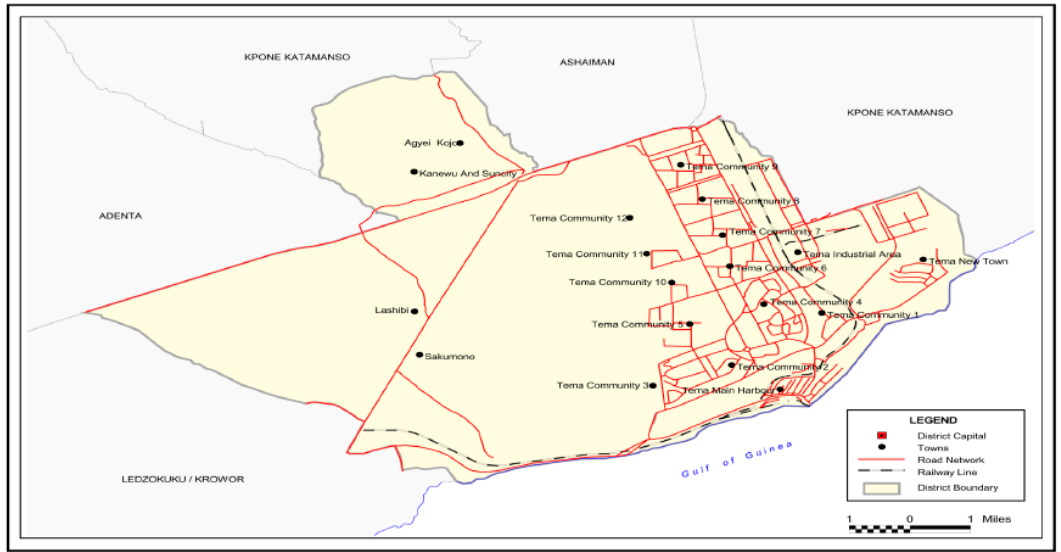
Figure 1. Map of Tema metropolitan area (Source: Ghana Statistical Service GIS unit).